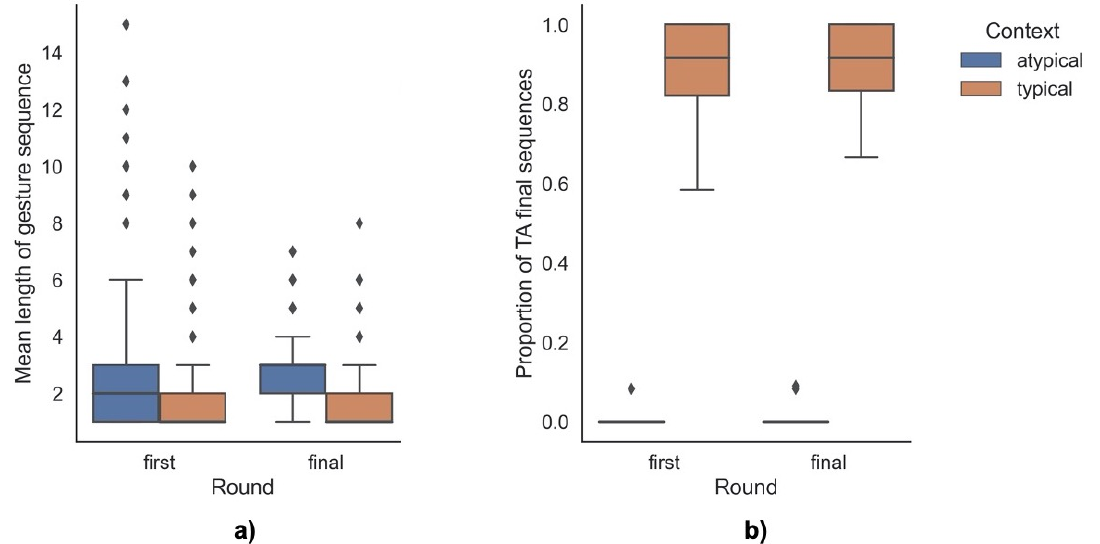
Figure 5. Mean gesture sequence length in terms of the number of individual gestures produced in a sequence ( a ) and Proportion of gesture sequences with a target action (TA) in final position ( b ), shown for each round and each context (typical/atypical).